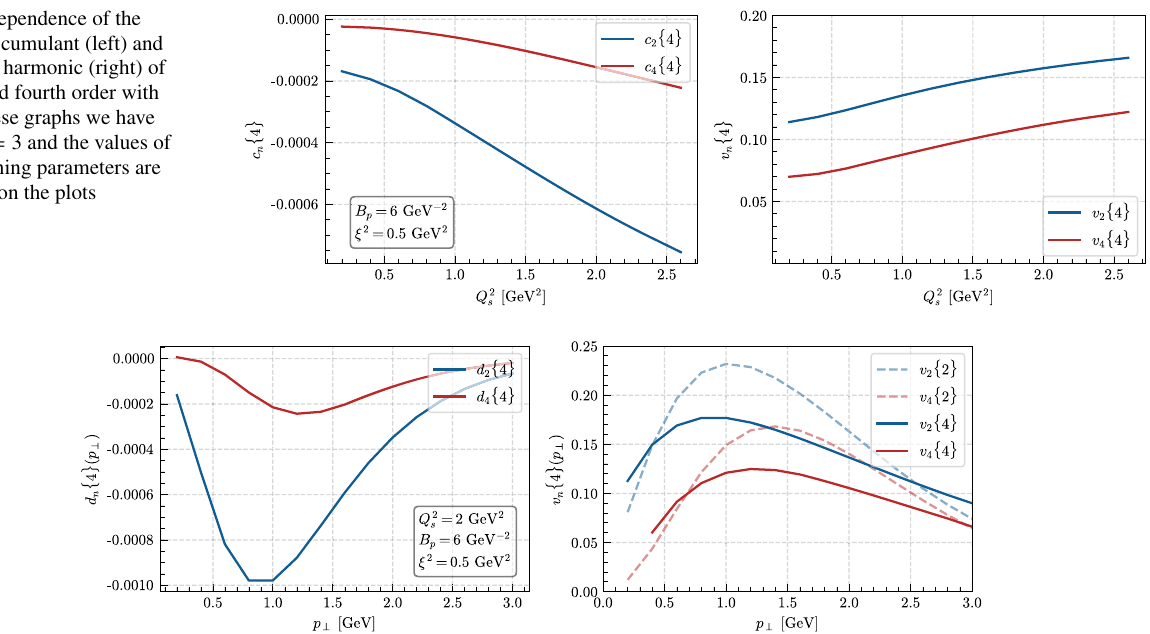
Fig. 8 Dependence of the differential 4-particle cumulant (left) and azimuthal harmonic (right) of second and fourth order with p ⊥ . For the latter we also show the results obtained from 2-particle correlations. In these graphs we have used N c = 3 and the values of the remaining parameters are indicated on the